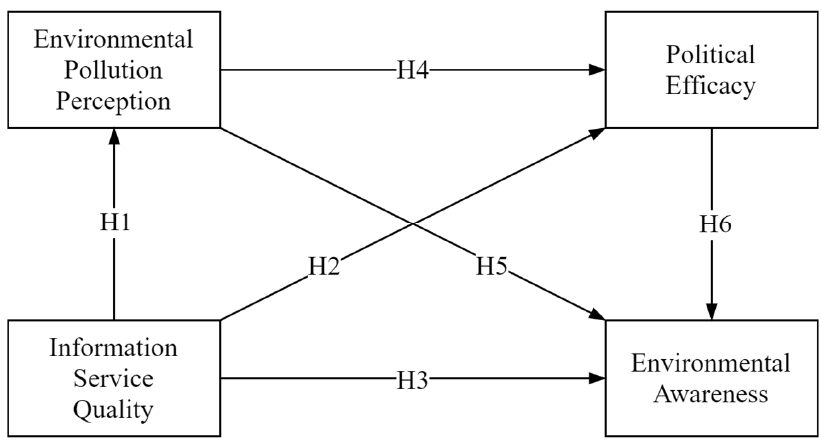
Figure 1. The influence mechanism of public environmental awareness.